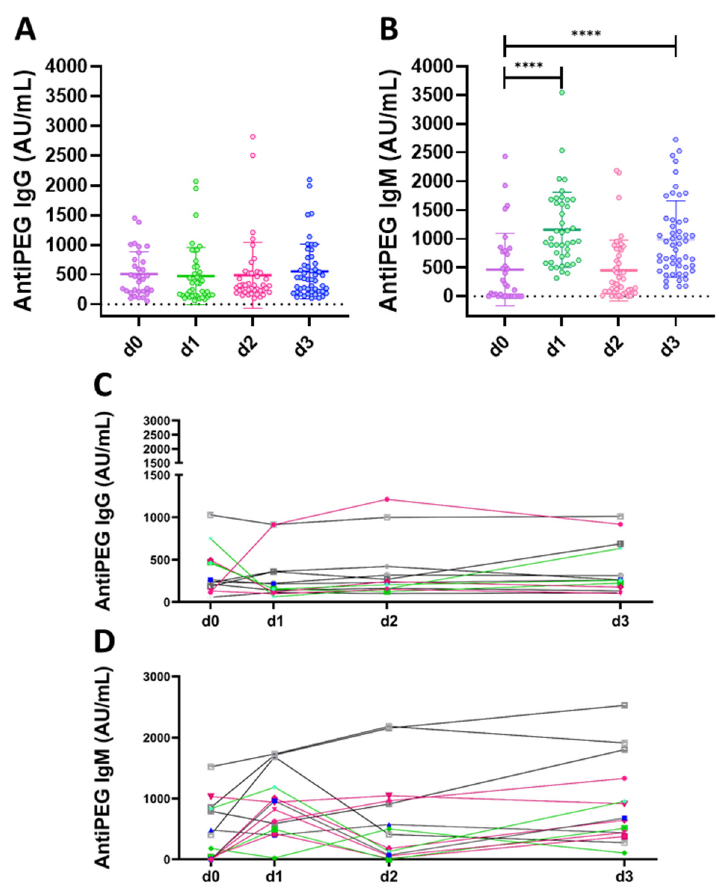
Figure 2. Anti-PEG antibodies following lipid nanoparticles-mRNA COVID-19 vaccination (BioNTech/Pfizer or Moderna). Anti-PEG IgG ( A ) and anti-PEG IgM ( B ) measured in heathy donors before vaccination and seven days after each vaccine dose (d0, d1, d2 and d3, respectively). Longitudinal analysis of anti-PEG IgG ( C ) and anti-PEG IgM ( D ), different colours represent different healthy donors. Kruskal–Wallis test, followed by Dunn’s post-test for multiple comparisons, was used for assessing statistical differences between groups (**** p ≤ 0.0001).